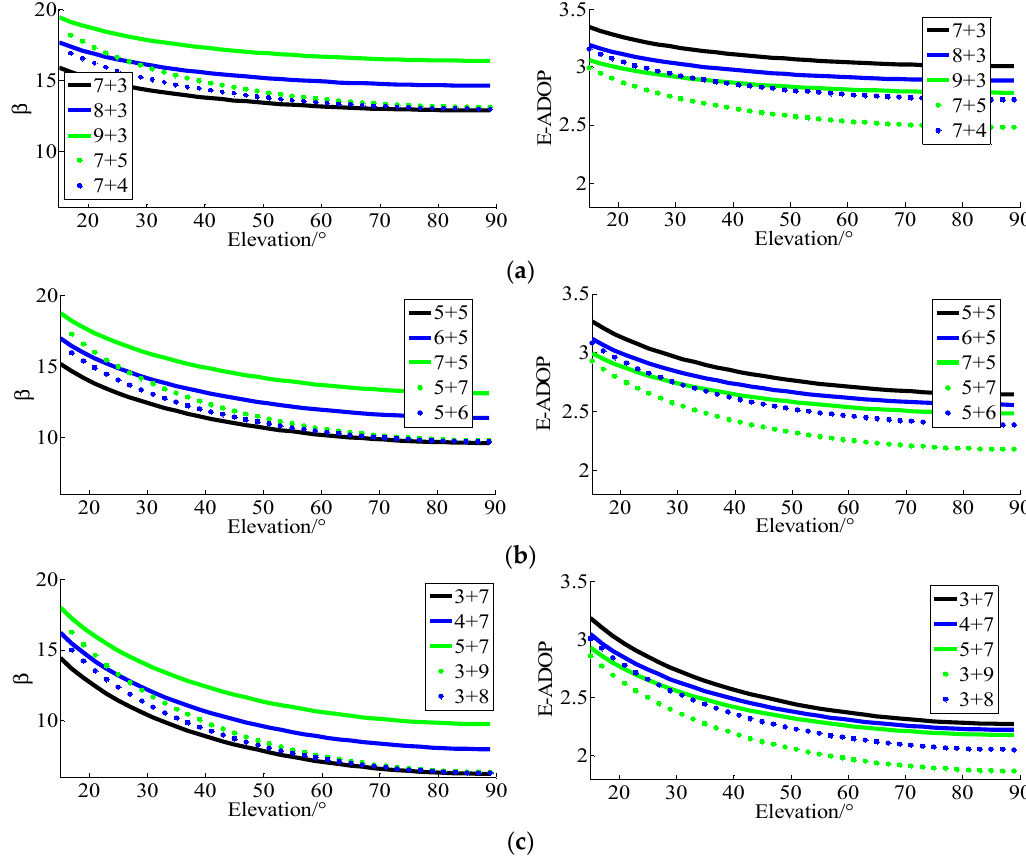
Figure 1. SMRW and E-ADOP of three groups of satellites. ( a ) The β and E-ADOP of (7 + 3) satellites. ( b ) The β and E-ADOP of (5 + 5) satellites. ( c ) The β and E-ADOP of (3 + 7)